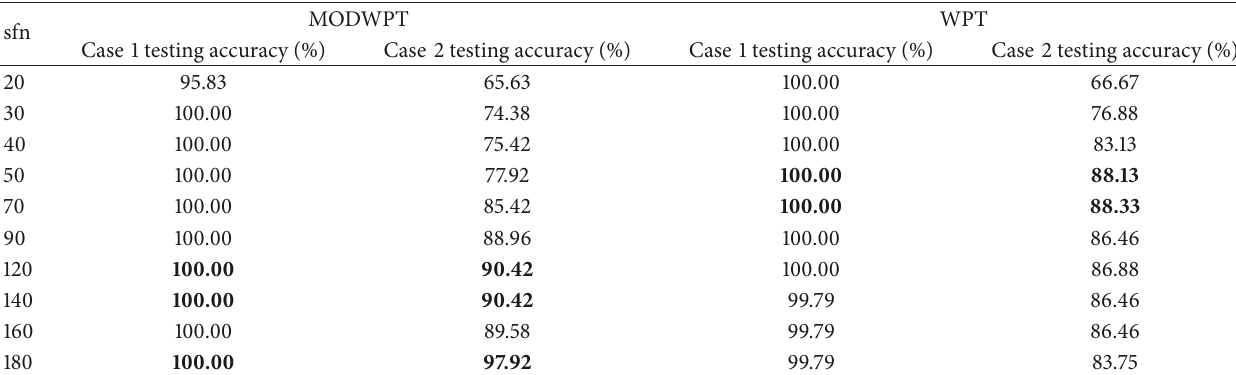
Table 11: Bearing fault diagnosis results obtained by OFS-FSASD-LDA-SVM (dimension size is 11).